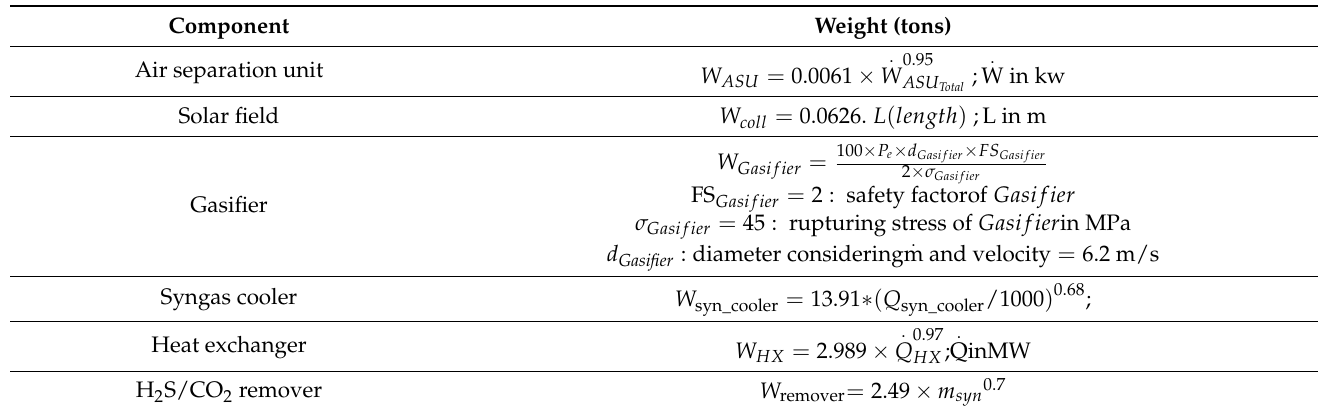
Table A5. Weight of different system components